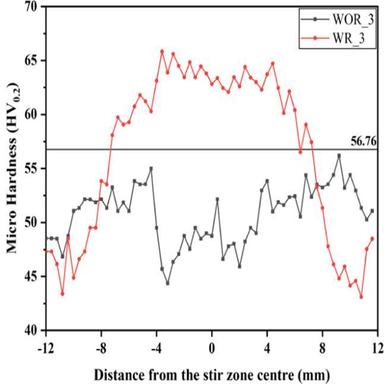
Micro indentation Vickers hardness test. The solid horizontal line shows Base material's hardness.